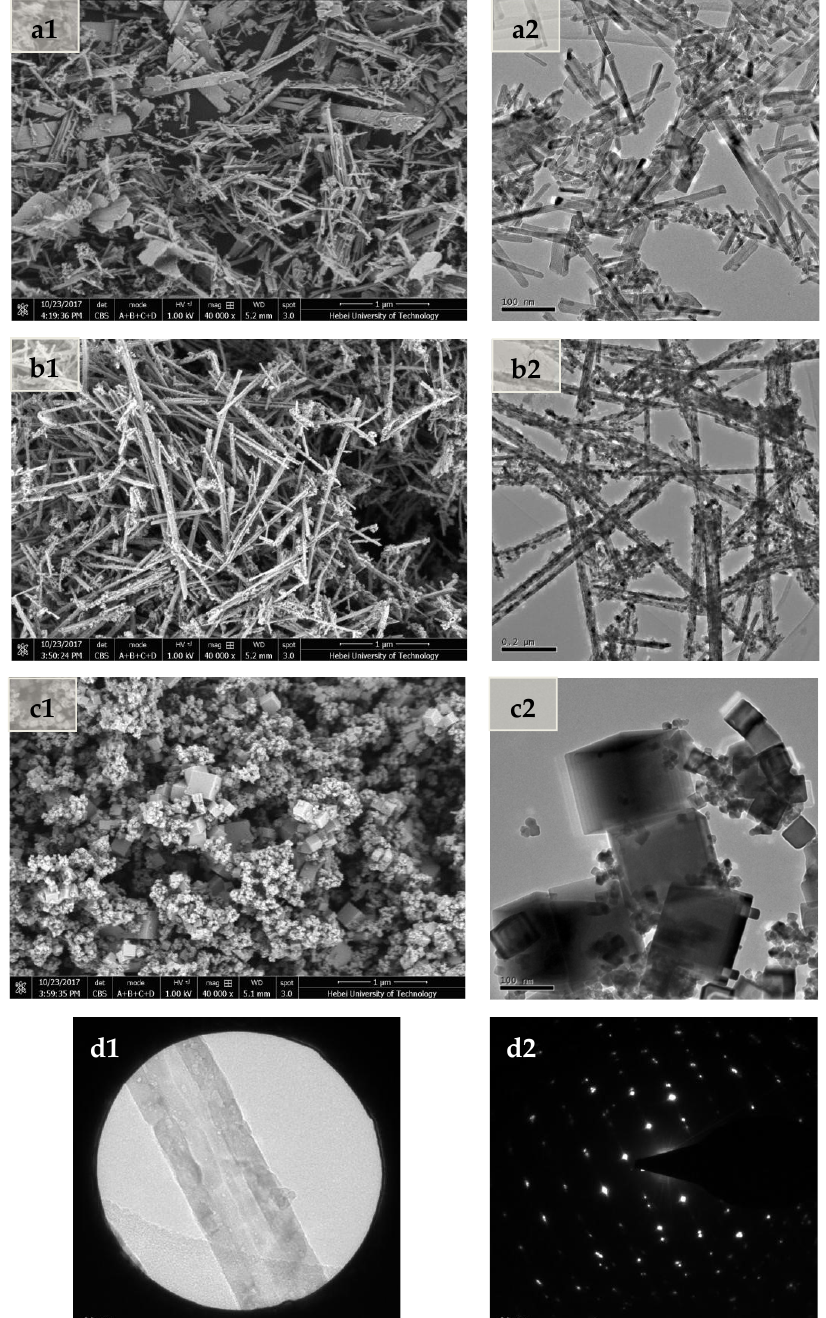
Figure 2. SEM and TEM images of CeO 2 with different morphologies. ( a1 , b1 , c1 ) are SEM images of CeO 2 -R, CeO 2 -T and CeO 2 -C; ( a2 , b2 , c2 ) are TEM images of CeO 2 -R, CeO 2 -T and CeO 2 -C; ( d1 , d2 ) are SAED of CeO 2 -T.